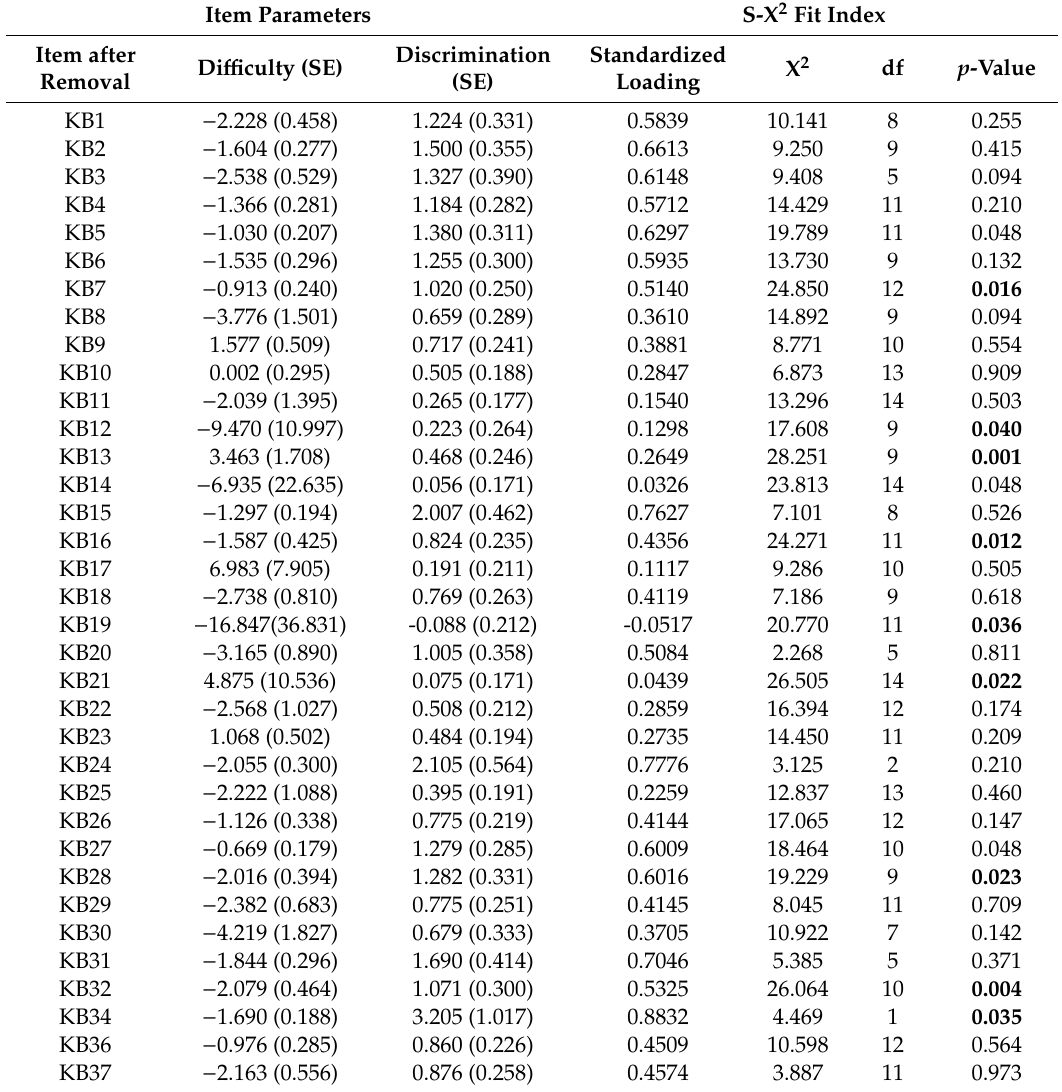
Table 4. Item Response Theory parameters estimate of knowledge items in complementary